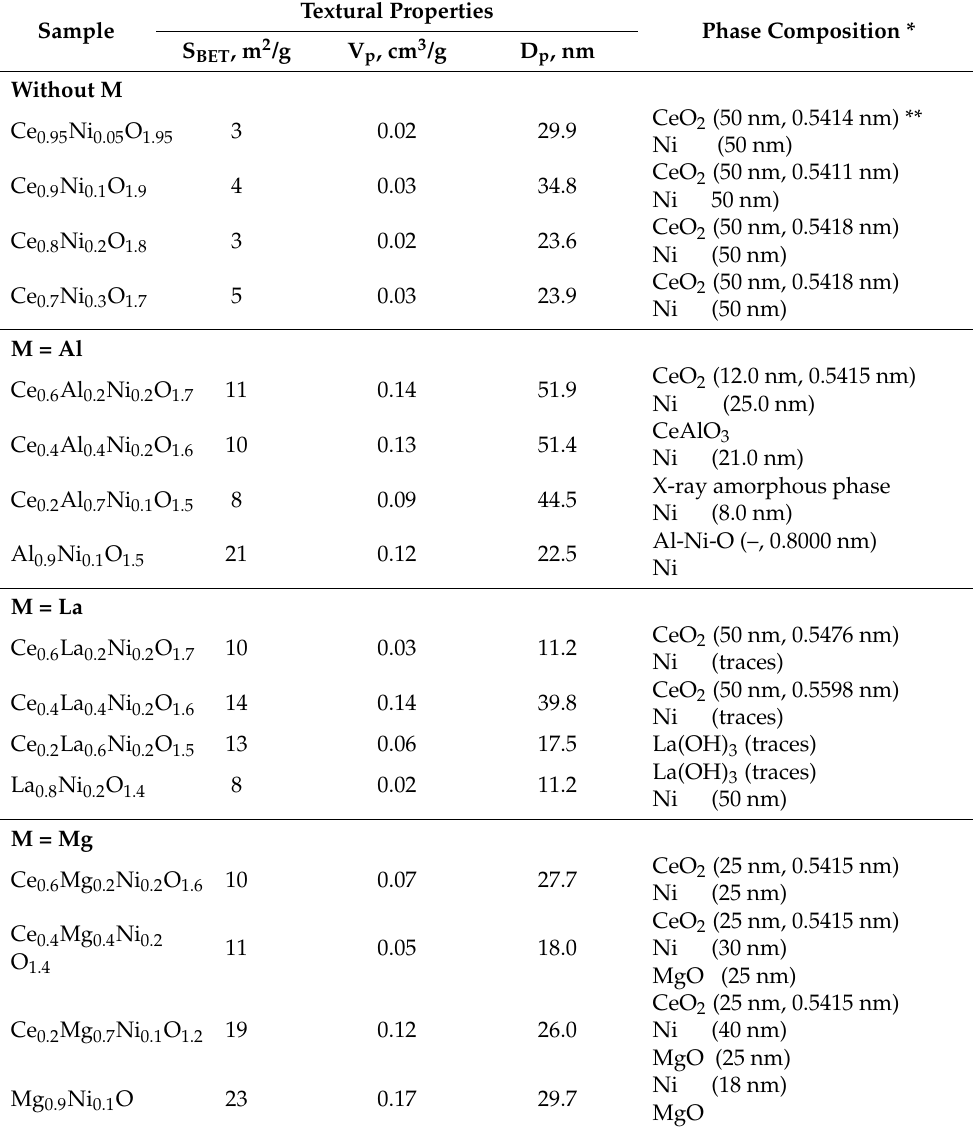
Table 5. Textural properties and phase composition of spent (CeM) 1 − x Ni x O y